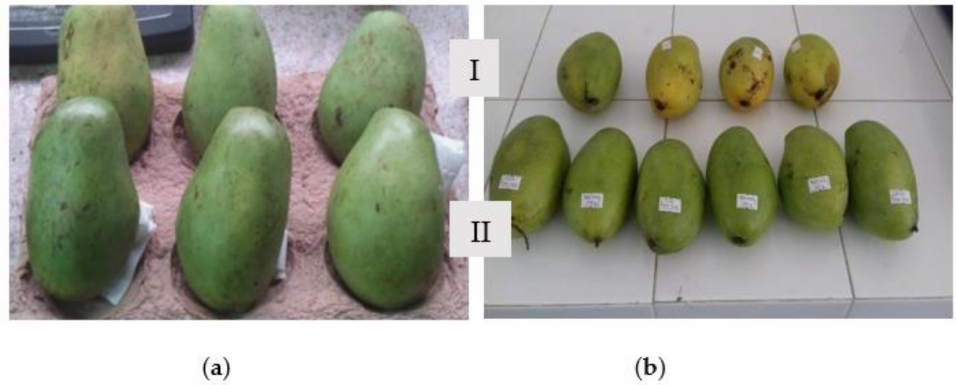
Figure 10. The color of mangoes at 0th day storage ( a ) and 9th day storage ( b ) at 32 ◦ C: Inner row (I): the control sample (un-coated); outer row (II): 2% P/NaCS